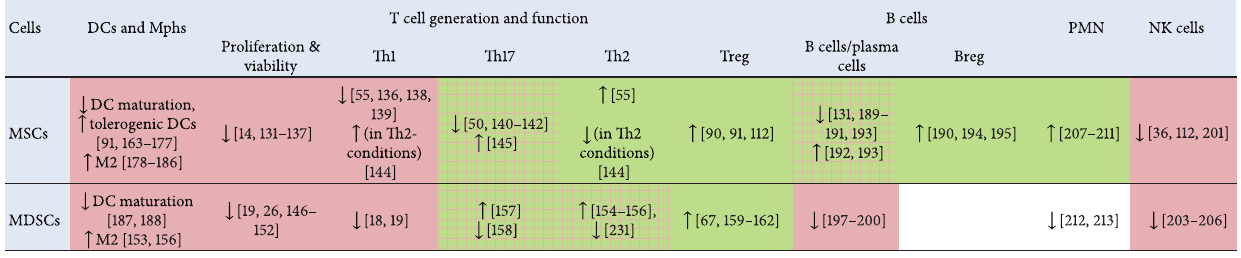
Figure 2: Cellular targets and modulatory effects of MSCs and